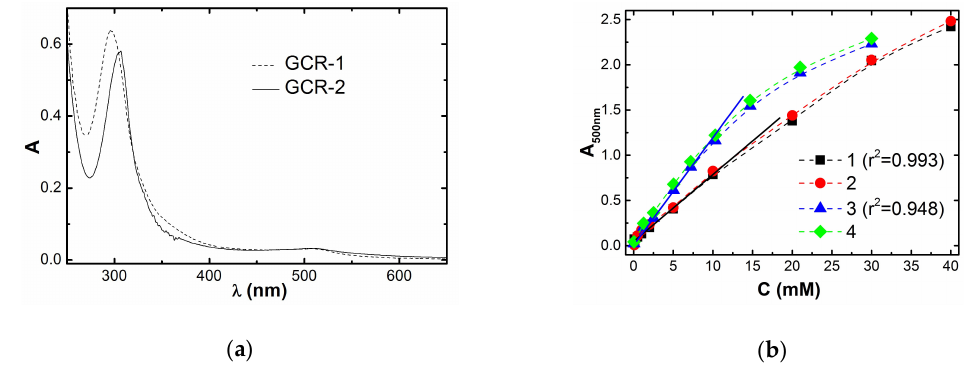
Figure 3. ( a ) UV absorption spectrum of water solution of 0.4 mM GCR-1 and 0.5 mM GCR-2, optical way 0.1 cm. ( b ) Concentration dependence of absorption at 500 nm: 1, water solution of GCR-1; 2, Sudan I in water solution of GCR-1; 3, water solutions of GCR-2 in the presence of two-fold excess of MG; 4, Sudan I in water solutions of GCR-2 in the presence of two-fold excess of MG, optical way 0.1